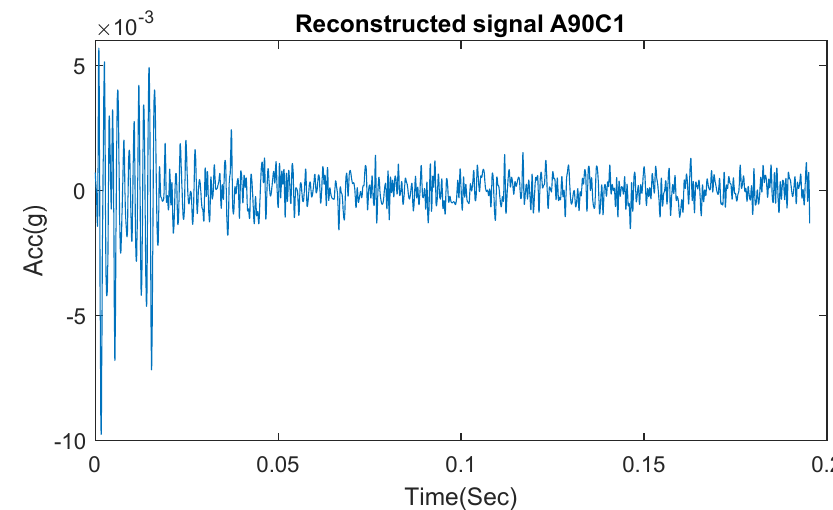
Figure 14. Example of reconstructed signal considering A90C1 at (5,0) node.